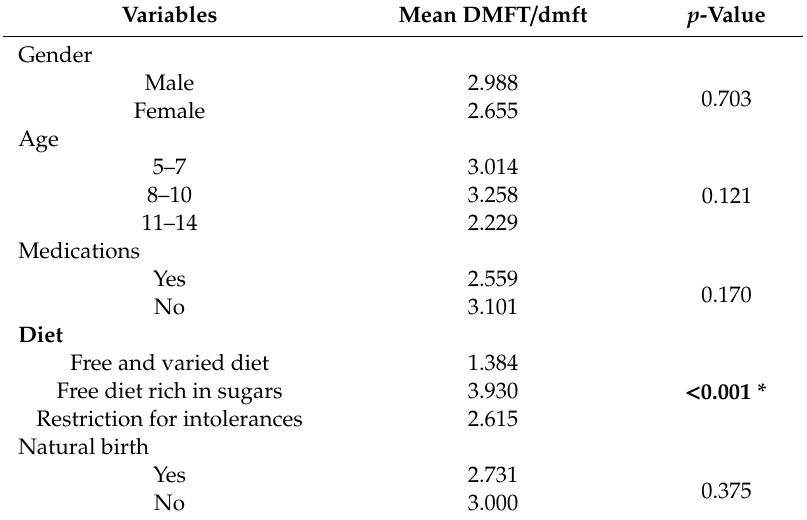
Table 4. Caries severity in relation to background and behavioral variables. p -values < 0.05, corresponding to statistically significant di ff erences, are marked with an asterisk and the corresponding variable is highlighted in bold.